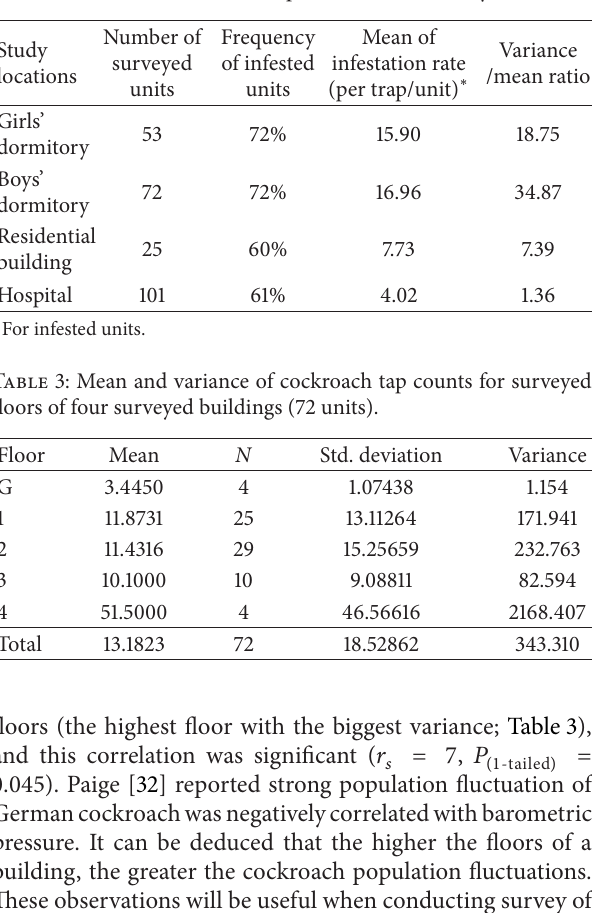
Table 2: Mean of cockroach trap counts for four study locations.